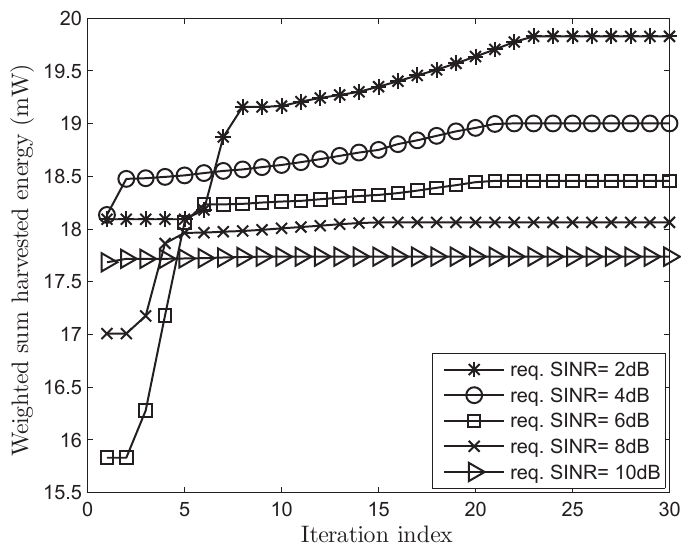
The iteration behavior of the proposed PSO-based algorithm when the required signal-to-interference-plus-noise ratios (SINRs) are given as 2, 4, 6, 8, and 10 dB, respectively, and a random imperfect CSI is